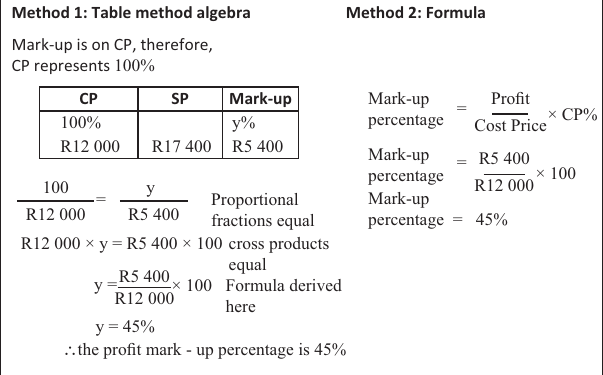
FIGURE 5 : Solution profit percentage